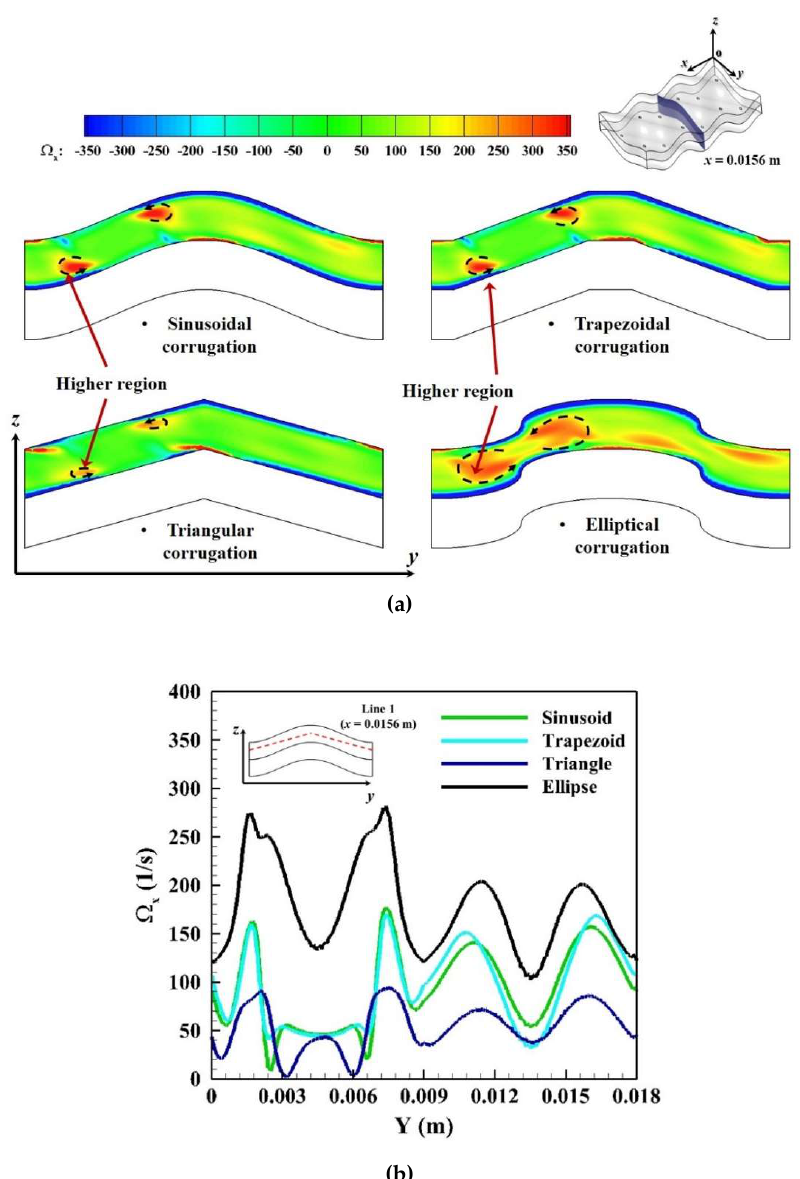
Figure 11. Streamwise vorticity distributions with respect to corrugation profiles: ( a ) at x = 0.0156 m and ( b ) along Line 1.